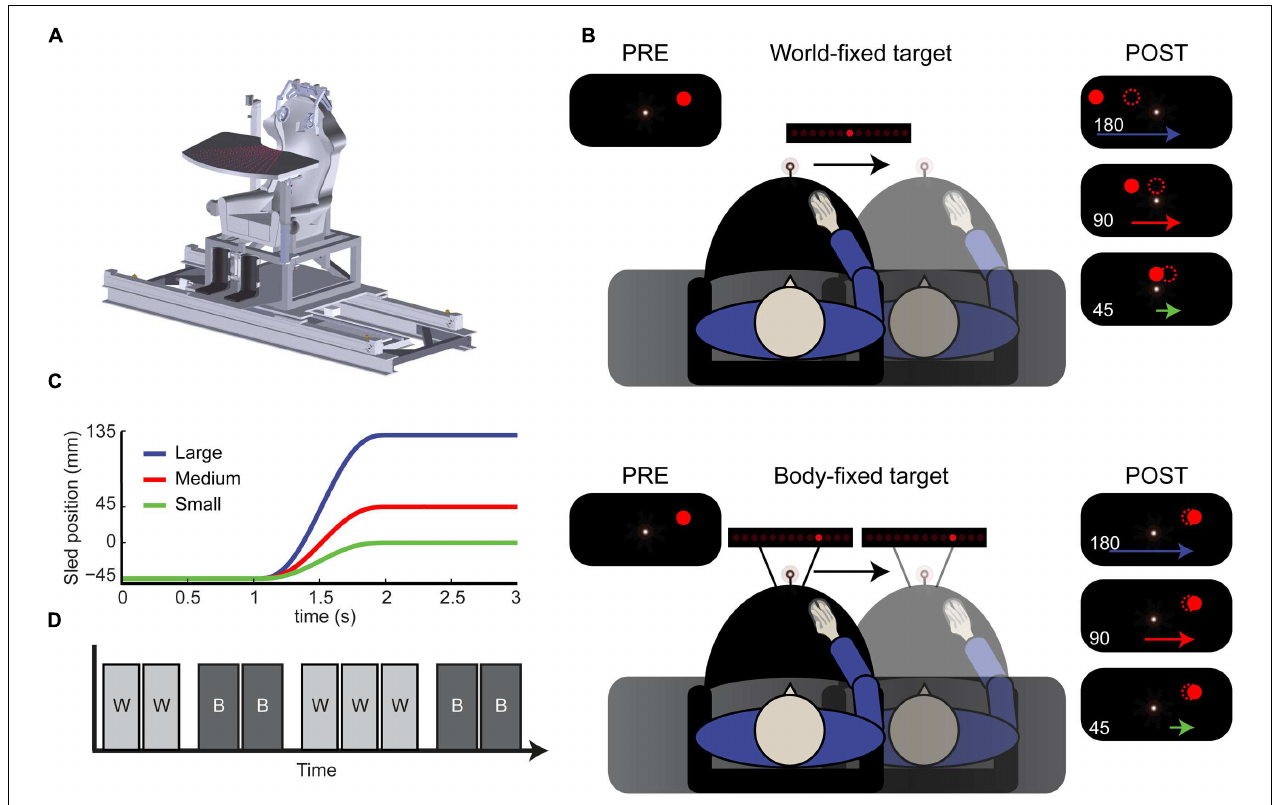
FIGURE 1 | Paradigm. (A) Schematic drawing of the vestibular sled. (B) Top view of the experimental setup. Subjects performed a spatial updating task with world-fixed (top) and body-fixed (bottom) targets. Using a sled-mounted fixation, a target was flashed, resulting the percept shown in the top left inset. After displacement, either 180, 90, or 45 mm subjects indicated where the remembered target was (dotted circle). This was generally underestimated in the world-fixed condition (compare with filled dots, the actual location). (C) Motion profiles of the large (180 mm), medium (90) and small (45) displacements. (D) Example of condition block order. W, world-fixed; B, body-fixed. Conditions alternated every two or three blocks and started with either world or body-fixed